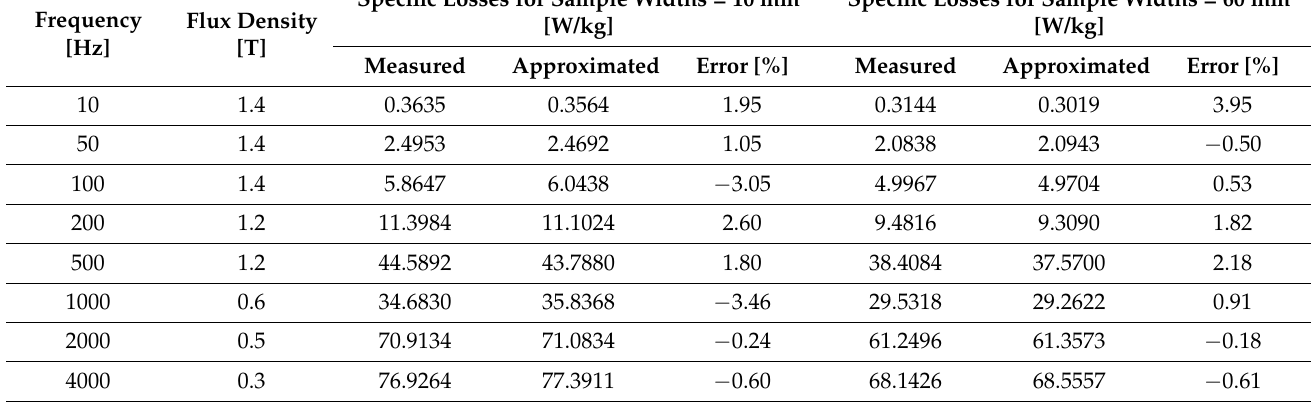
Table 5. Exemplary the differences between experimental and simulation results for the M270-35A sheet cut with a guillotine.